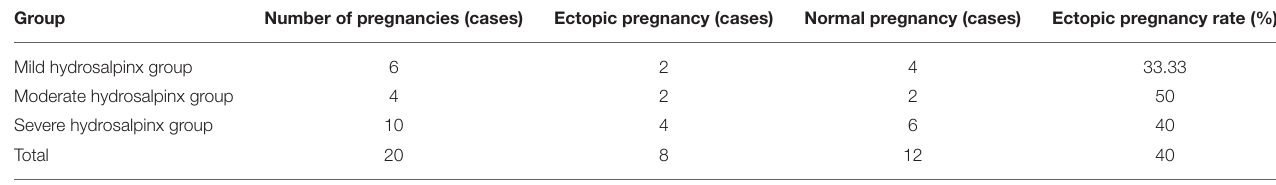
TABLE 7 | Hydrosalpinx and ectopic pregnancy. Group Number of pregnancies (cases) Ectopic pregnancy (cases) Normal pregnancy (cases)